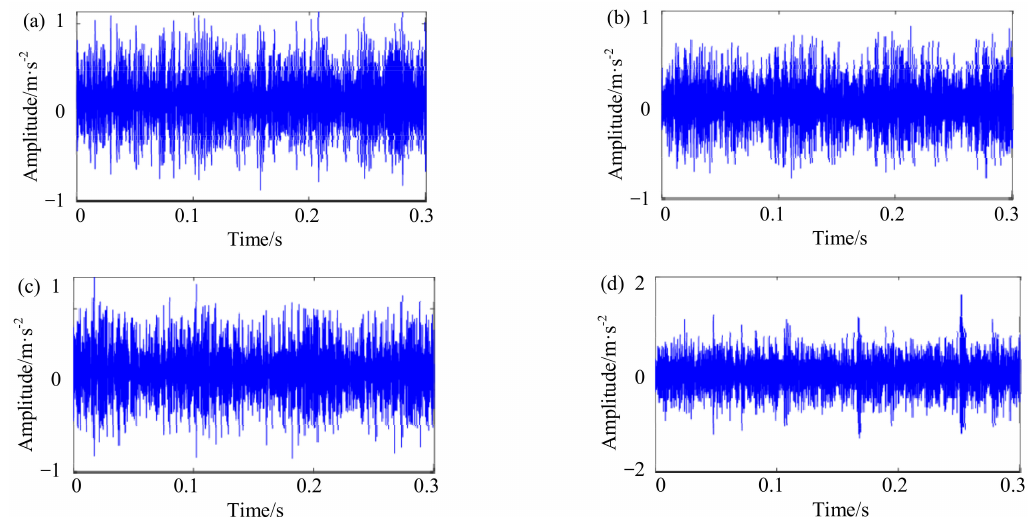
Figure 4. The test bench system of IWM.